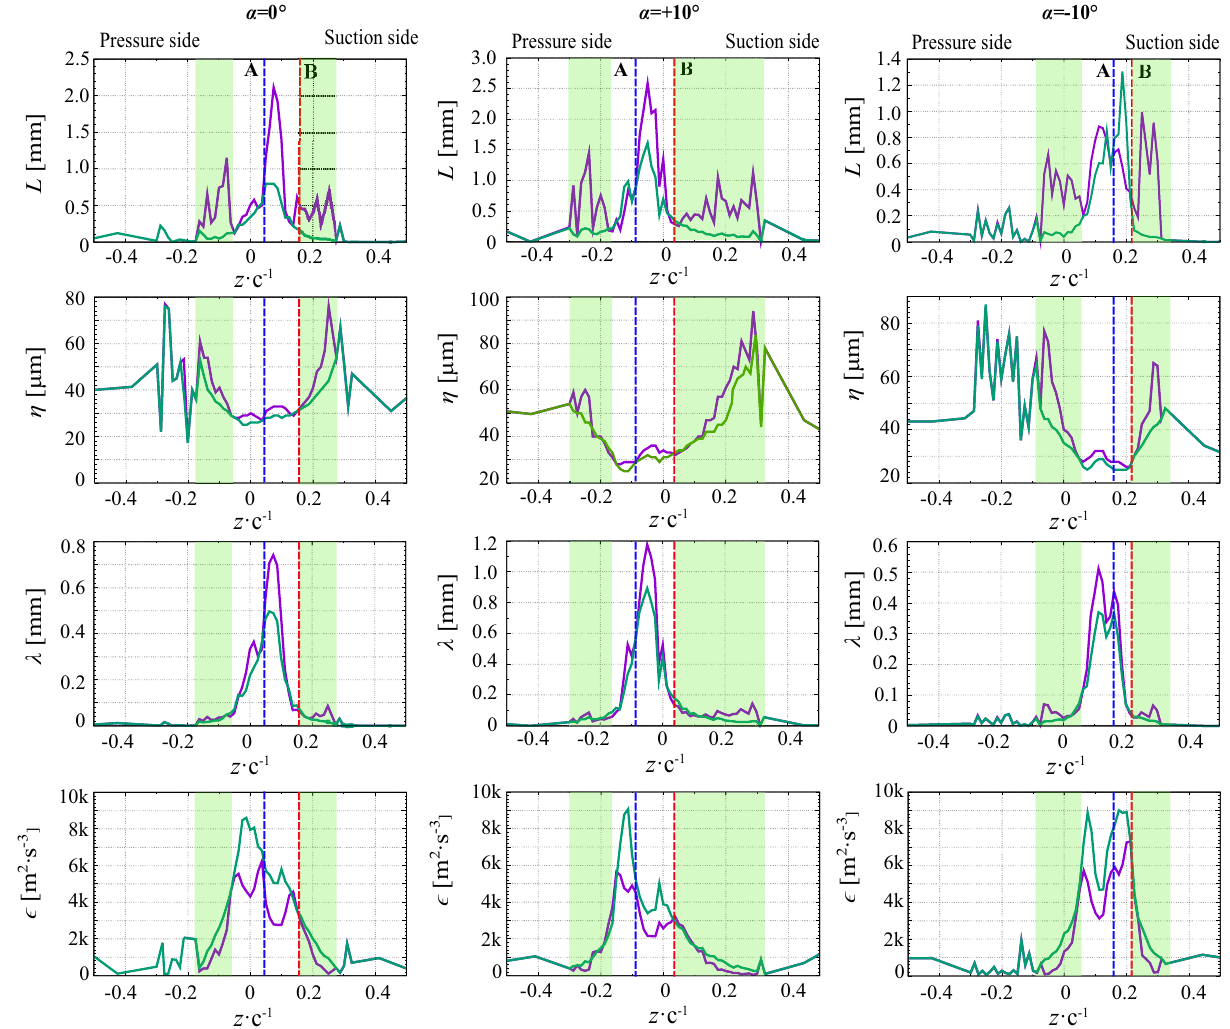
respectively. The green color indicates the range of the shear layer. Meanwhile, the blue and red dashed lines indicate the positions of points A and B,